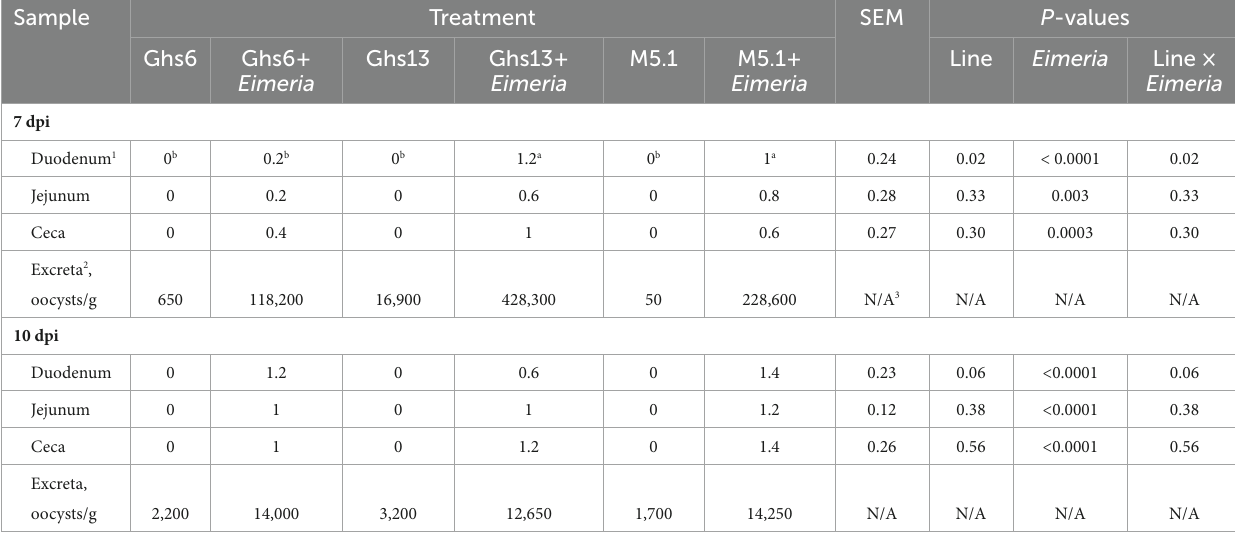
TABLE 2 Average intestinal lesion scores and oocyst counts in Leghorn (Ghs6 and Ghs13) and Fayoumi (M5.1) inbred genetic lines ±10X Coccivac-B52 (Merck Animal Health, Kenilworth, NJ).